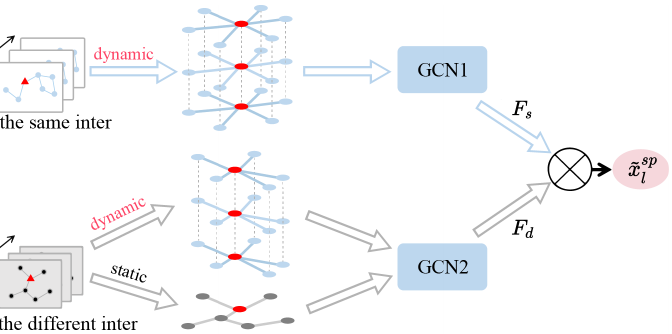
Figure 5. Internal graph convolutional network based on dynamic graph